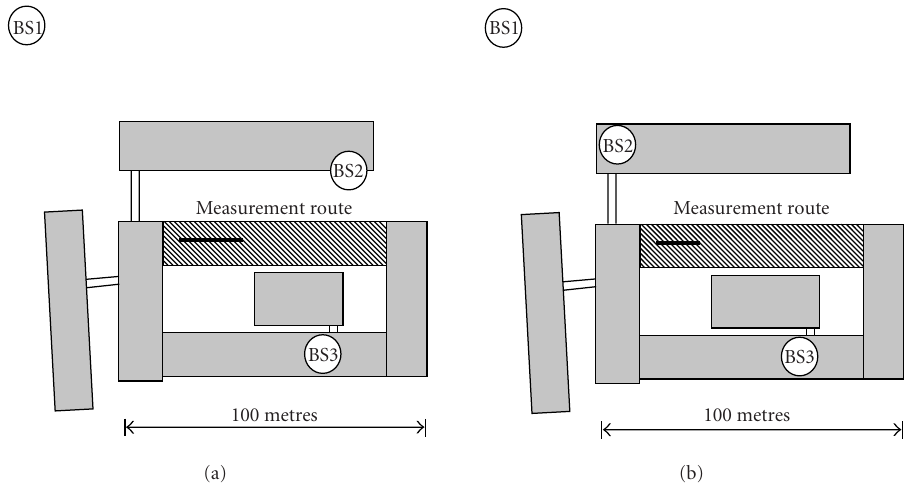
Figure 2: Measurement situations and BS configurations for the outdoor-to-indoor campaign: (a) star configuration for the old building and (b) inline configuration for the old building.